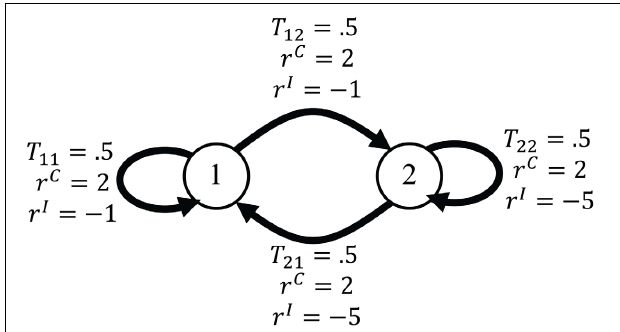
FIGURE 6 | The SMDP corresponding to the second example in section 3.3. In the example each trial could come from one of two conditions and so the corresponding SMDP has two states. The states are shown by circles. The arrows show transitions between states. The probability of each transition and the reward that the agent receives after each transition are written on the